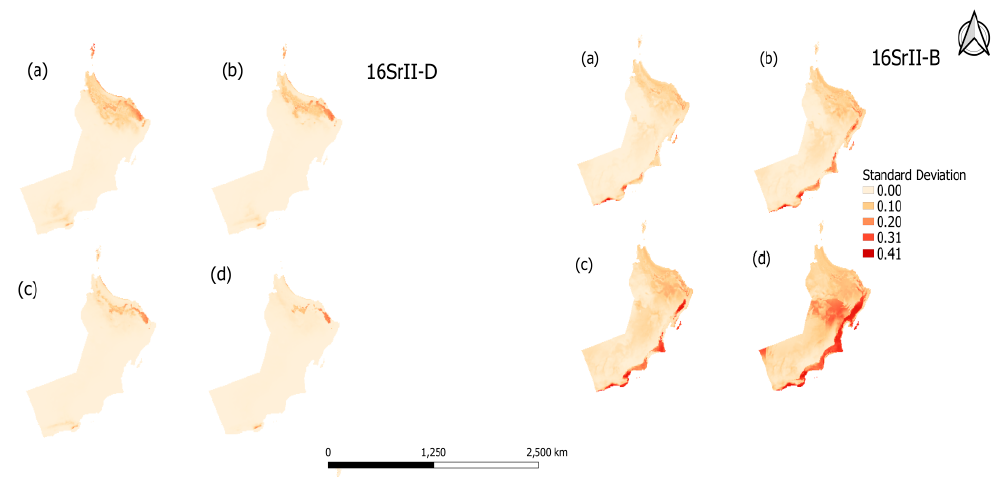
Figure 7. The standard deviation maps of 16SrII-D and 16SrII-B habitat distribution in maximum entropy (MaxEnt) for climatic projections ( a ) 2021–2040 ( b ) 2041–2060 ( c ) 2061–2080, and ( d ) 2081–2100.